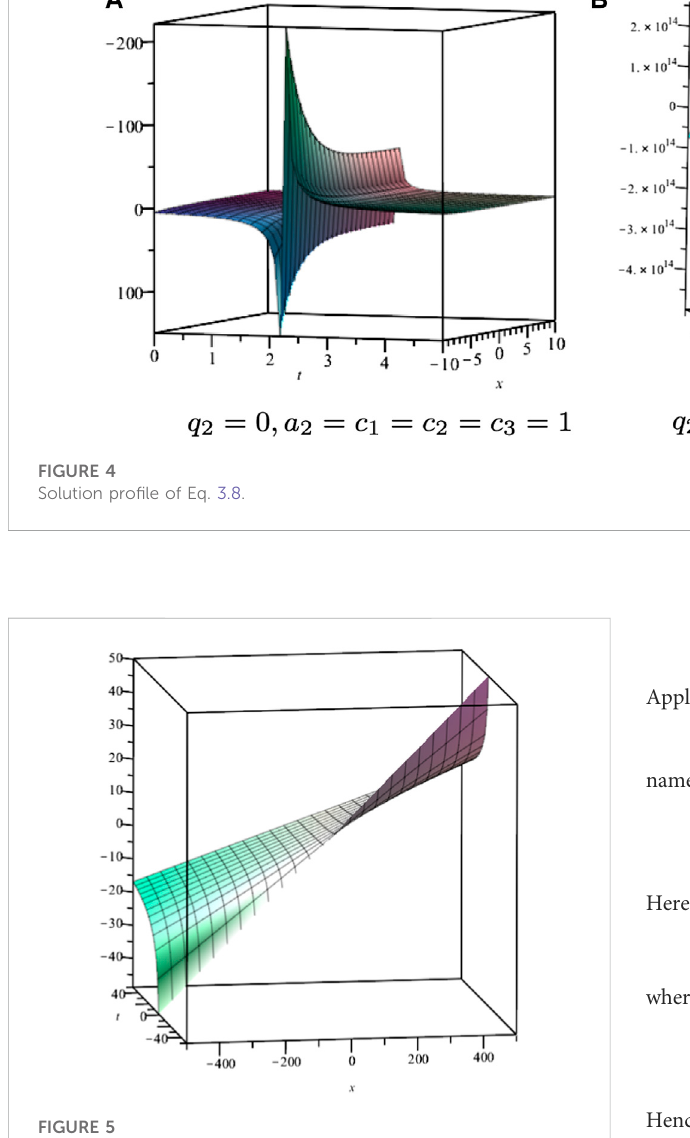
Solution pro fi le of Eq. 4.1 with α = 1/3, b 1 =